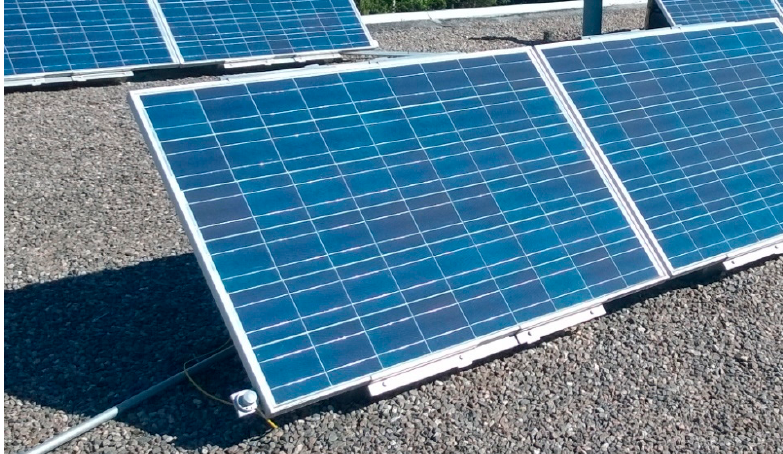
Figure 2. PV panel mounting and the pyranometer.